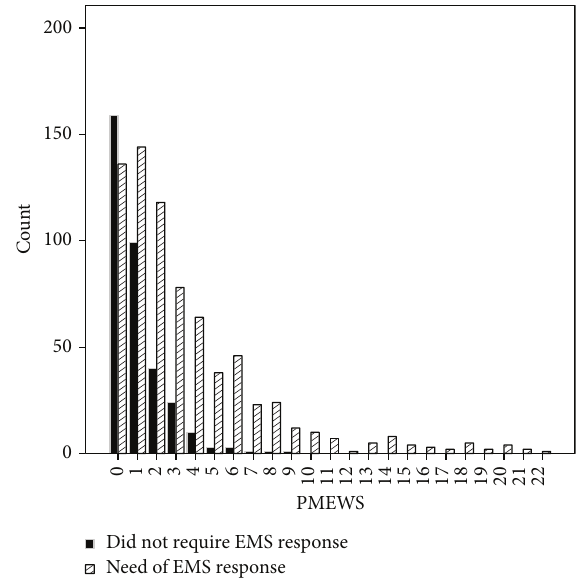
Figure 1: Distribution of the PMEWS in relation to final disposal.